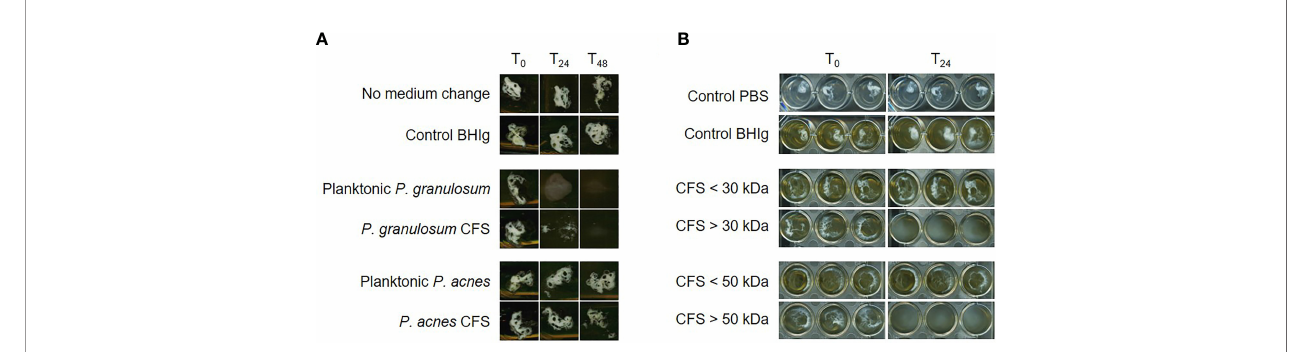
FIGURE 1 | P. acnes bio fi lm dispersion by P. granulosum cell ‐ free supernatant (CFS). (A) Dispersal of 6 days old P. acnes bio fi lms in fl ask after 24 and 48 hours CFS treatment. (B) P. acnes bio fi lm dispersion in 96-well plate after 24 hours treatment with different P. granulosum CFS